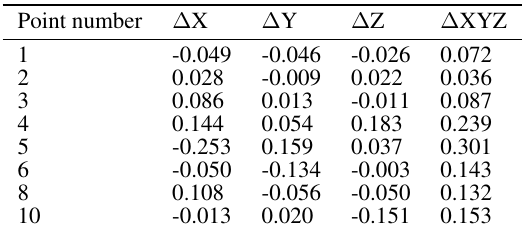
Table 2. Residuals in meter for 9 points transformed from the historical model into a metric coordinate system.